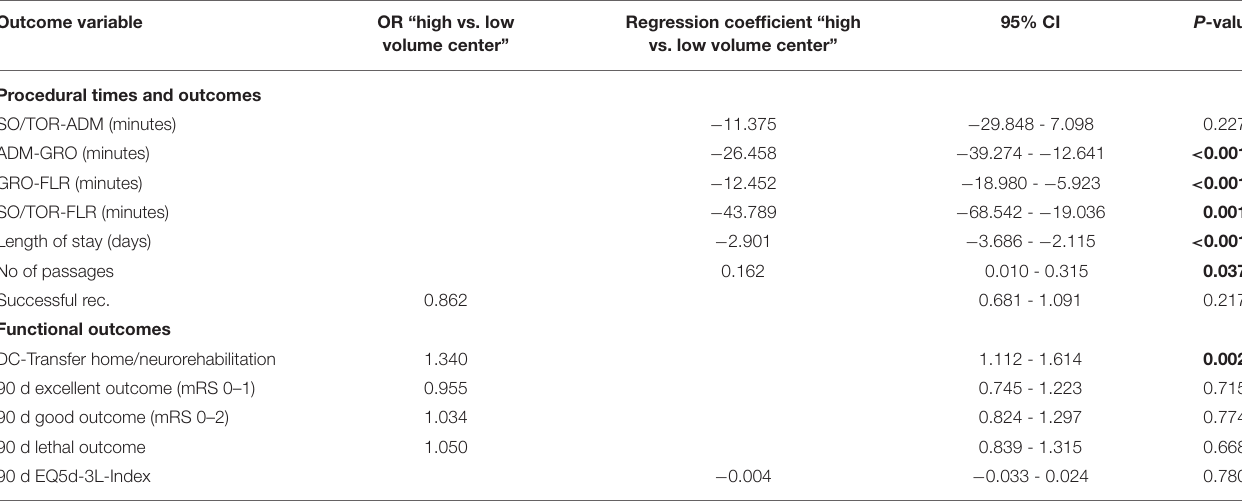
TABLE 3 | Odds ratios/regression coefficients for “high-” vs. “low-volume center” variable resulting from multiple logistic/linear regression analysis for procedural and functional outcome variables adjusting for baseline characteristics. Outcome